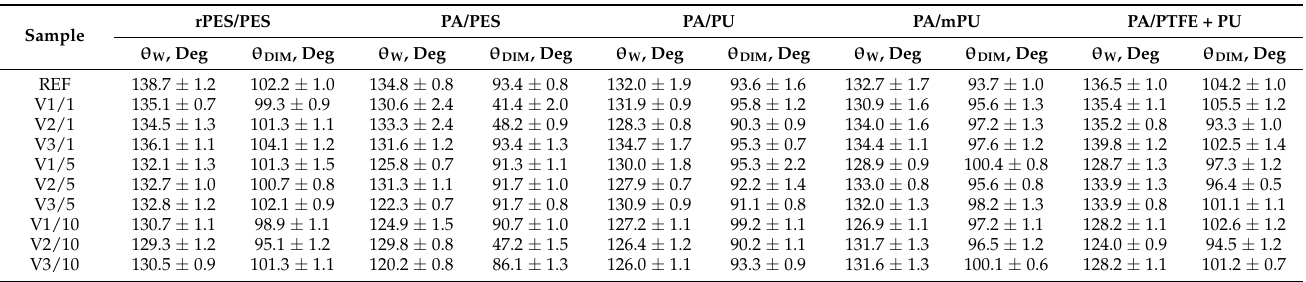
Table 8. The average values of water ( θ W ) and diiodomethane ( θ DIM ) contact angles and their standard deviation.